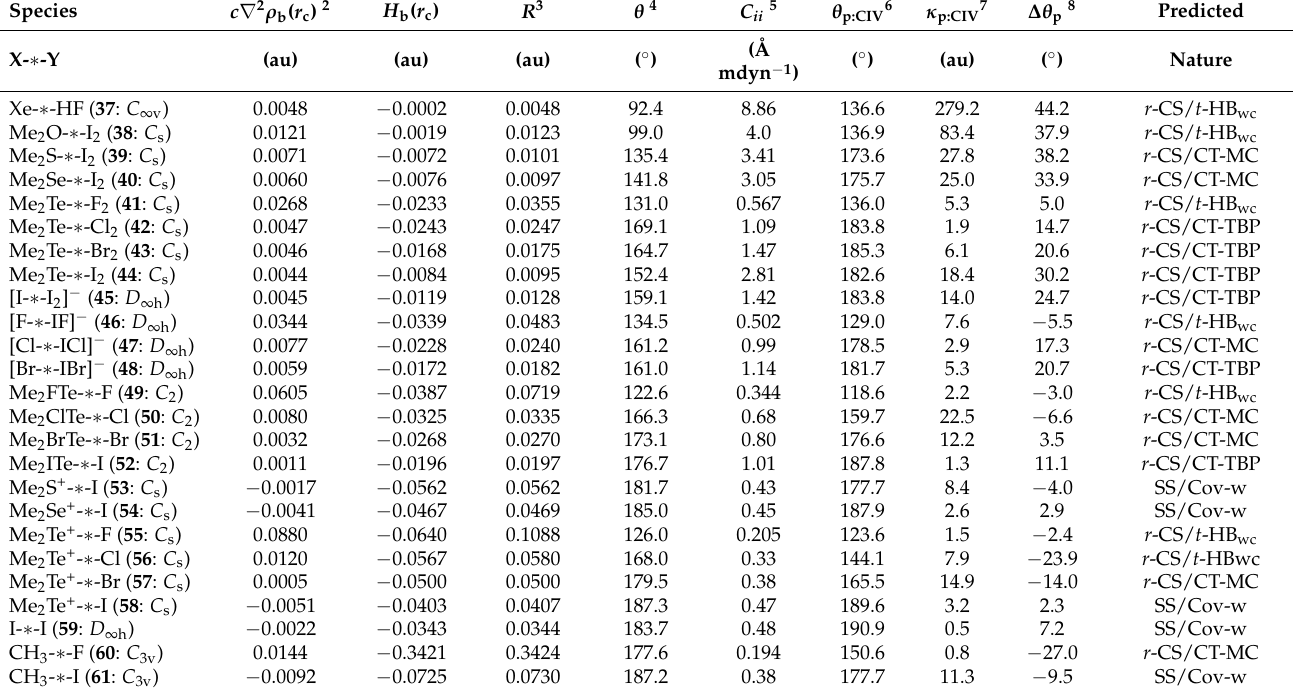
predicted natures. The ∆ θ p values were plotted versus θ for the data of 37 – 61 shown in Table 1. Figure 4 shows the plots. Table 1. The H b ( r c ) − V b ( r c )/2 and H b ( r c ) values and QTAIM-DFA parameters of ( R , θ ) and ( θ p , κ p ) for the standard interactions in 37 – 61 , together with the C ii , ∆ θ p values, and predicted natures, calculated with QTAIM-DFA under MP2/BSS-A’, employing the perturbed structures generated with CIV 1 .